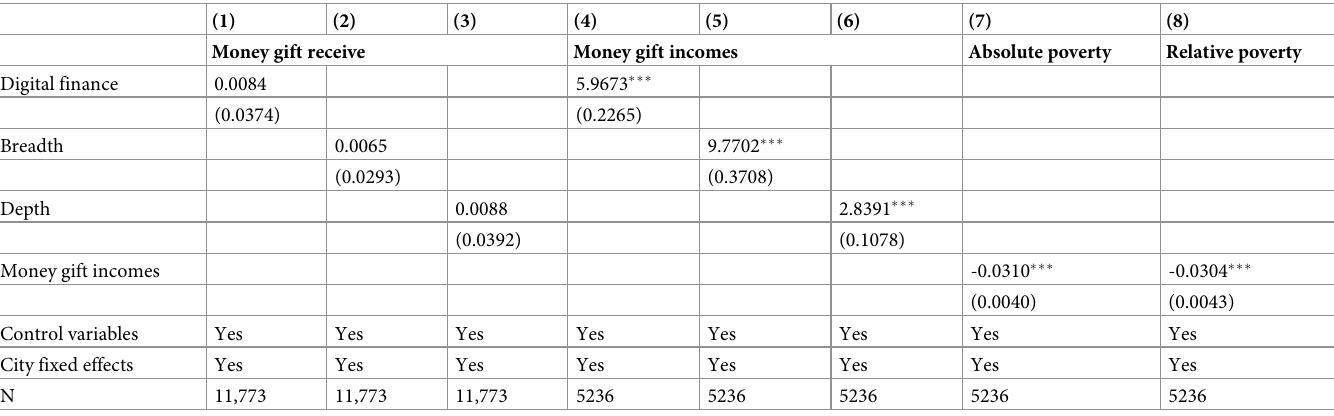
Table 9. Digital finance, social network, and rural household poverty (revenue related to social